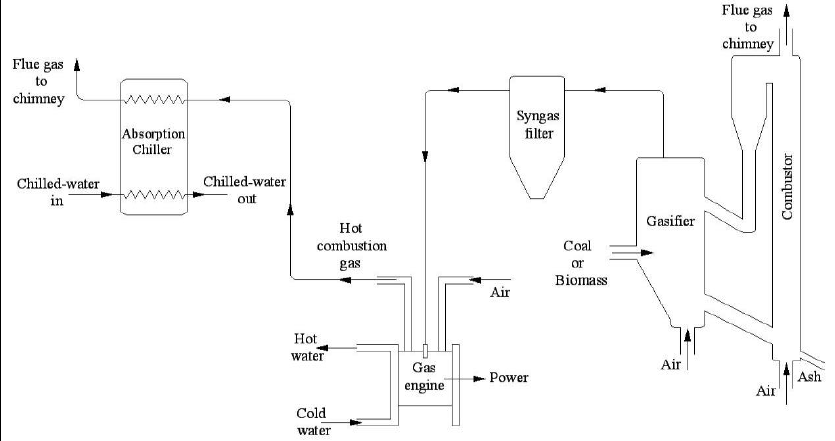
Fig. 1. Process flow sheet of the simulated trigeneration power plan.